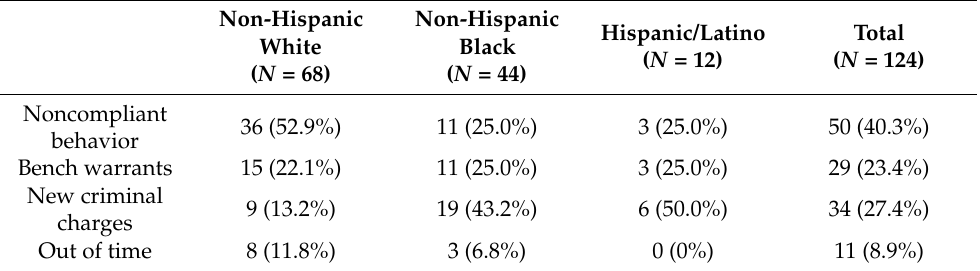
Table 6. Reasons for Revocation ( N = 124).